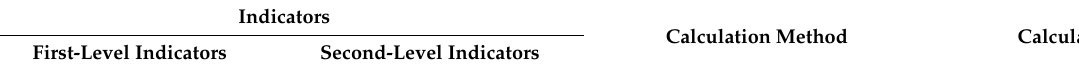
Table 2. Calculation and statistics of the influencing